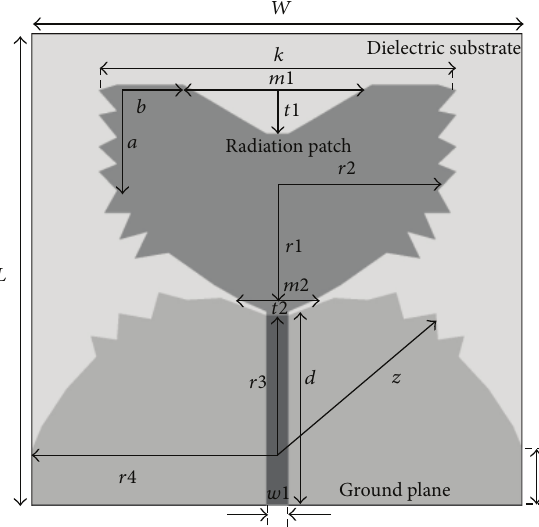
Figure1:GeometryoftheproposedUWBantenna.( 𝑤1 = 1.16 mm, 𝑚1 = 10 mm, 𝑚2 = 6 mm, 𝑡1 = 0.6 mm, 𝑡2 = 2 .1mm, 𝑧 = 13 mm,